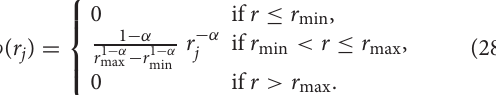
from eye approximation. From this crossover, we then